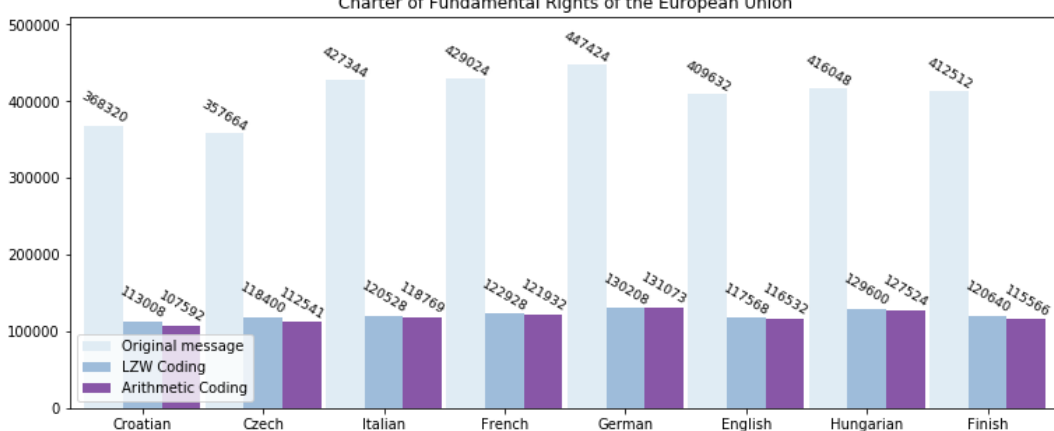
Figure 7. Encoding Charter of Fundamental Rights of the European Union.